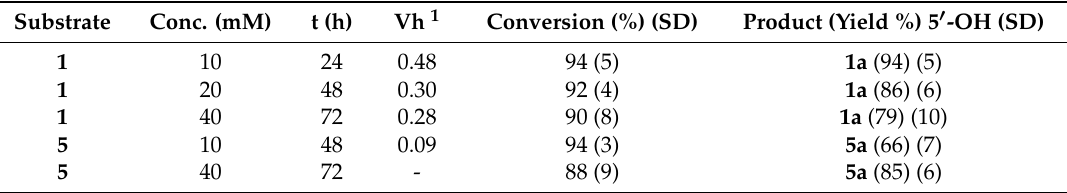
Table 5. Hydrolysis of substrates 1 and 5 at different